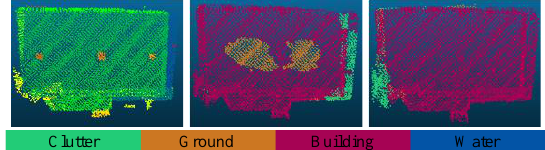
Figure 2. Segment entropy. Left: unsupervised segmentation results. Middle: high entropy within the roof segment. Right: low entropy within the roof